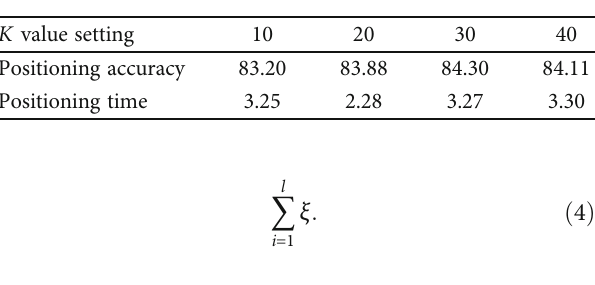
Table 3: Simulation results of tertiary positioning K value based on K -nearest neighbor method.